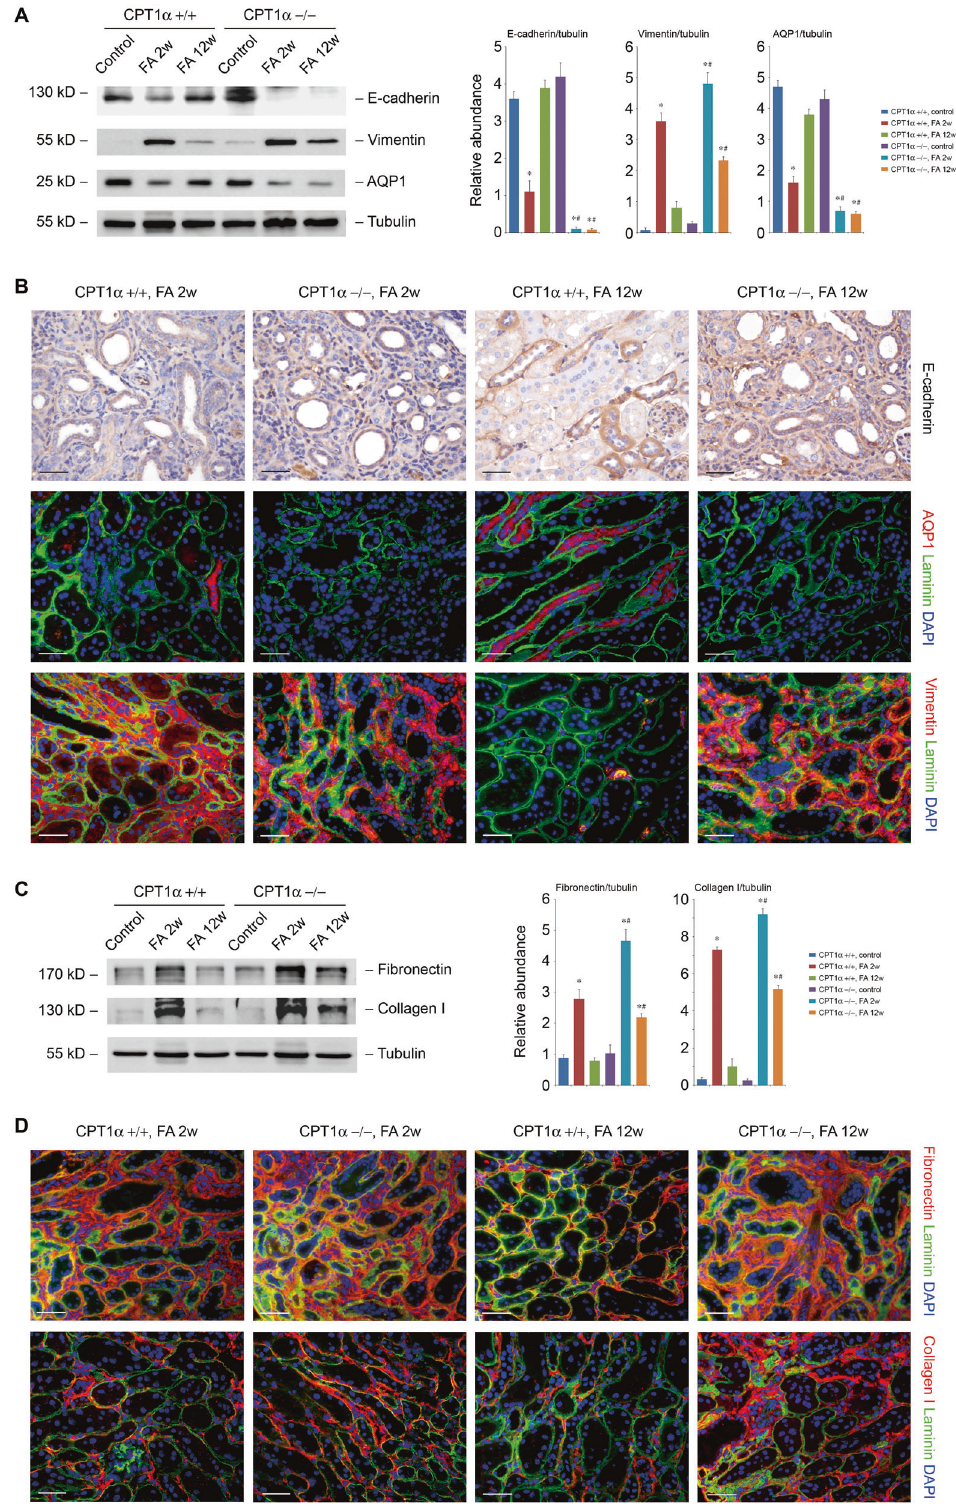
Fig. 4 CPT1 α is indispensable for preserve and recovery of tubular phenotype. A Western blot analysis of protein expression and graphic presentation of the relative abundance of E-cadherin, vimentin, and AQP-1 in kidney samples from groups as indicated. B Representative images of mice kidney samples immunostained with E-cadherin, AQP-1, and vimentin. C Western blot analysis of protein expression and graphic presentation of the relative abundance of fi bronectin and collagen I in kidney samples from groups as indicated. D Representative images of mice kidney samples immunostained with fi bronectin and collagen I. * P < 0.05 versus control. # P < 0.05 versus CPT1 α + / + . Scale bar, 50 μ m.